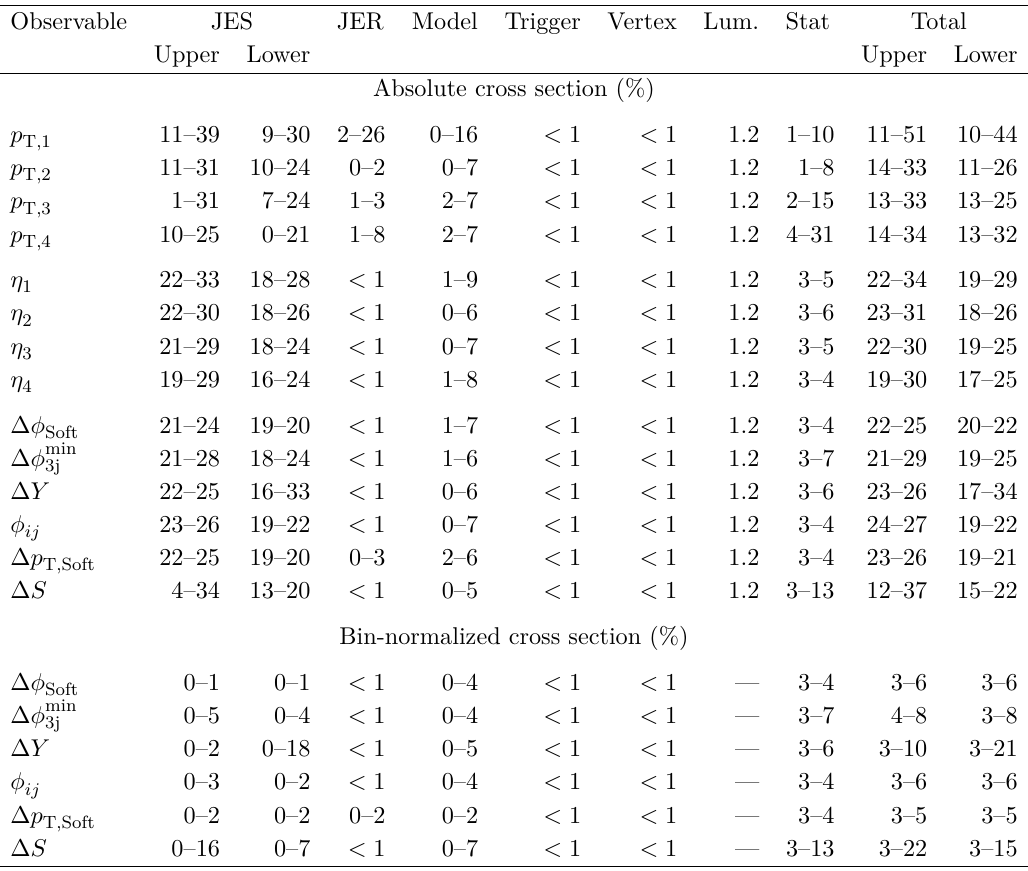
Table 1 . Systematic uncertainties, along with the statistical and the total uncertainties for the p spectra, the η spectra, and the DPS sensitive observables, in percent. The JES uncertainty leads to asymmetric uncertainties (an upper and a lower error), while all other systematic uncertainties, as well as the statistical uncertainty, are